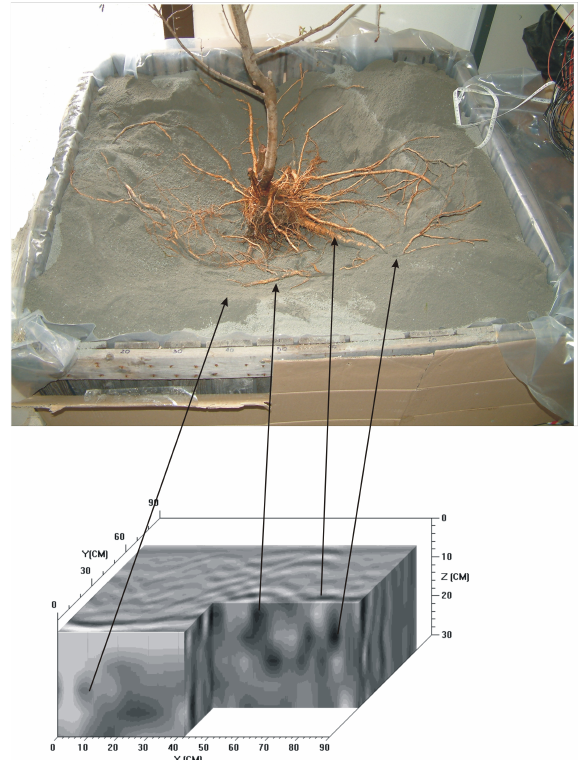
Fig. 3. Three-dimensional GPR image (1500MHz) for data col- lected along profiles parallel in woody box filled with clay and sand. The 3-D block reflects the root zone below the tree trunk, arrows indicate some sections of roots clearly visible. The depth of inves- tigation was